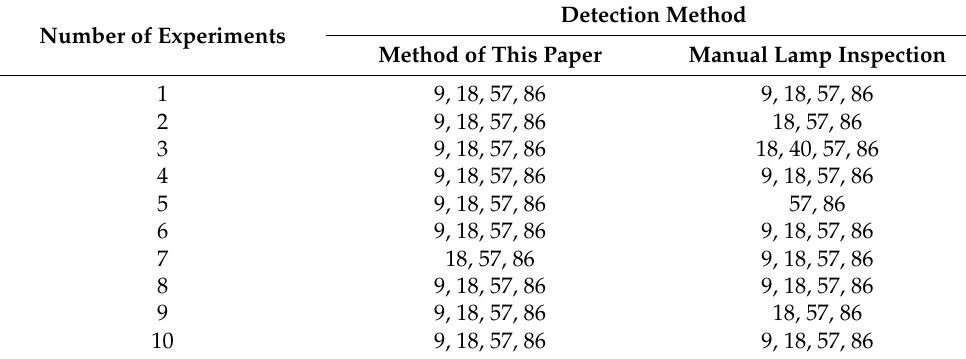
Table 5. Statistical result of repeatability